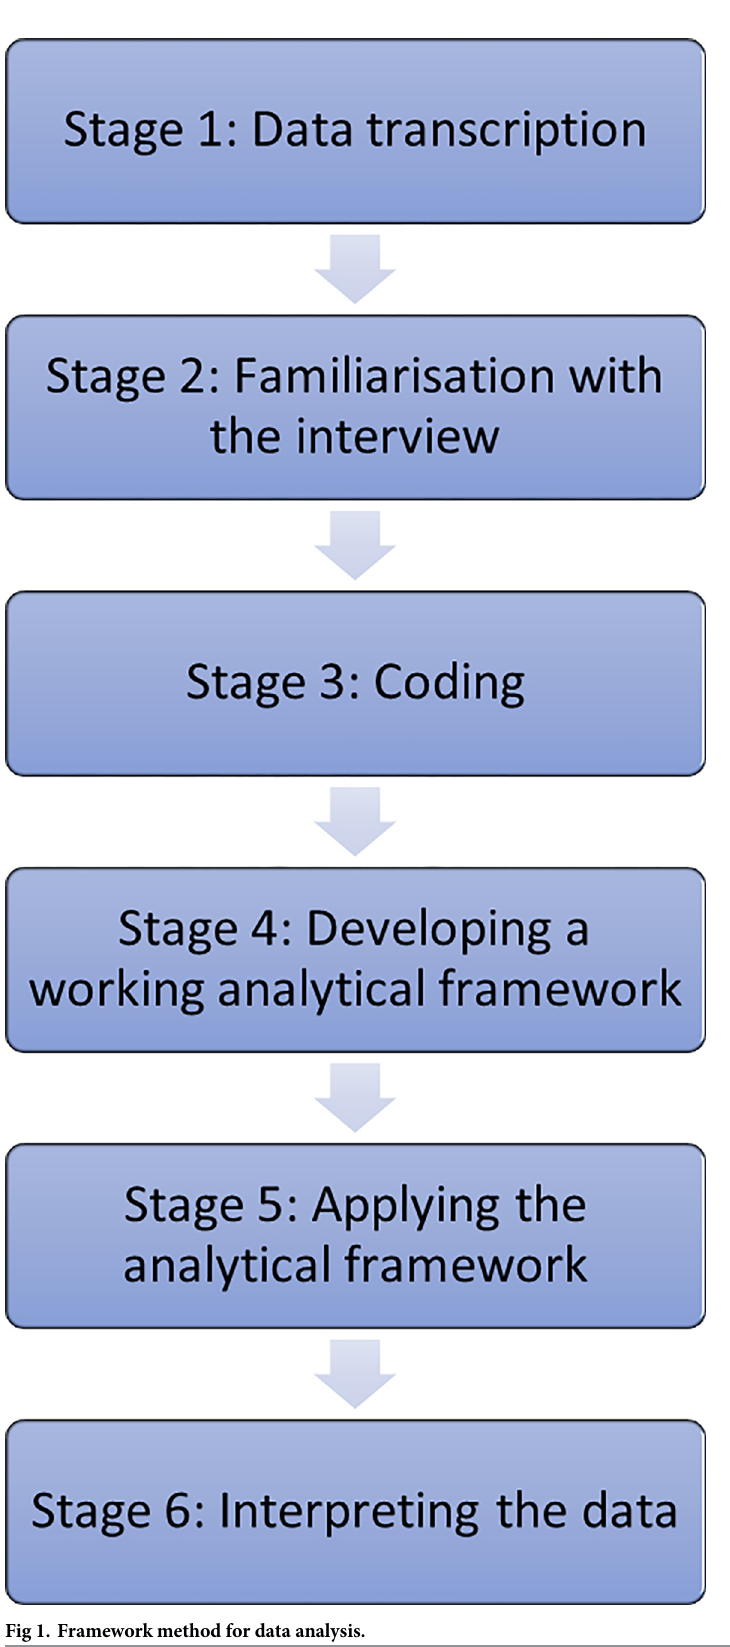
Fig 1. Framework method for data